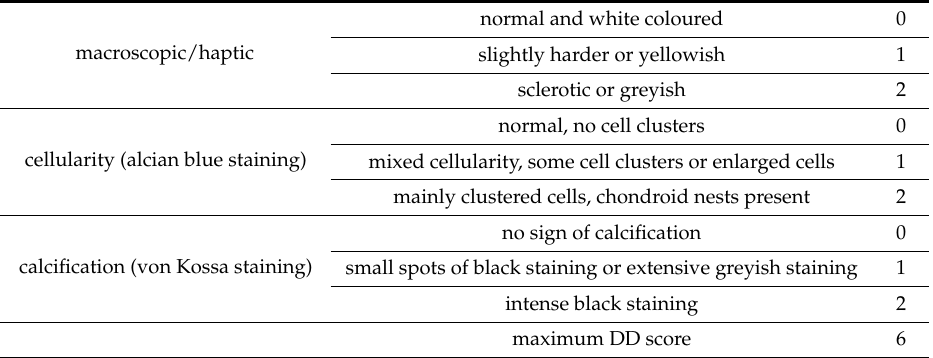
Table 3. Sample information and outcome of IVD and DD scoring of AF and NP tissues sampled from human cervical discs. MRI degeneration grade according to Miyazaki